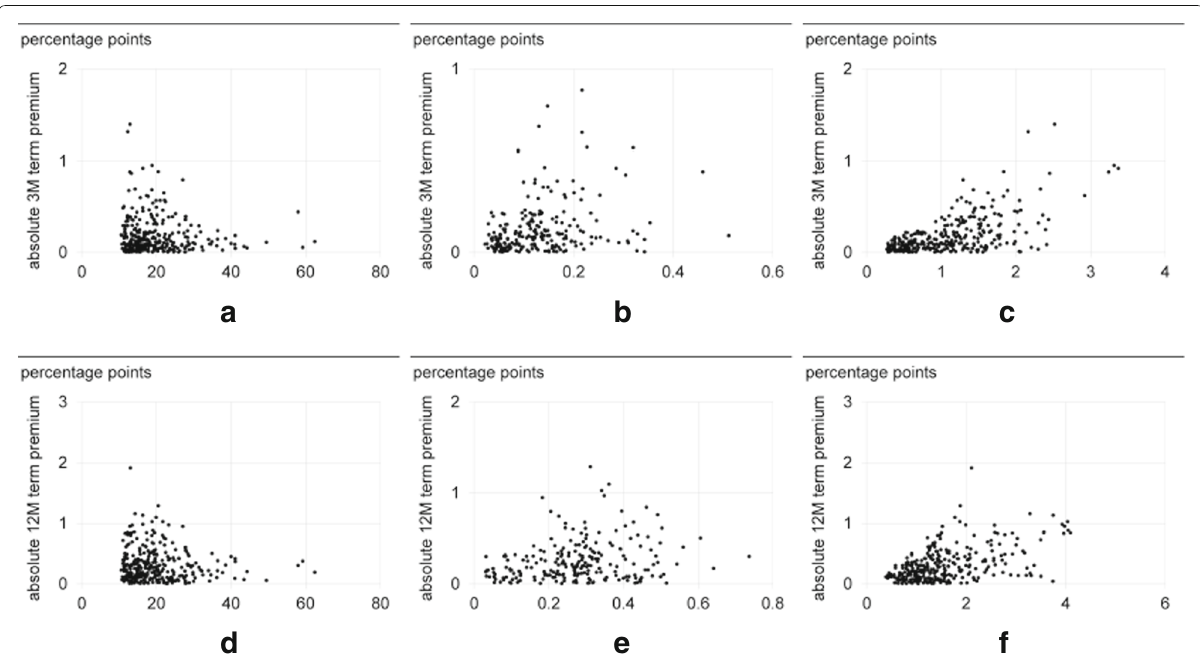
Fig. 5 Scatter plots of absolute term premium and uncertainty measures. The figure shows the scatter plots for the regressions reported in Table 9. a VIX. b